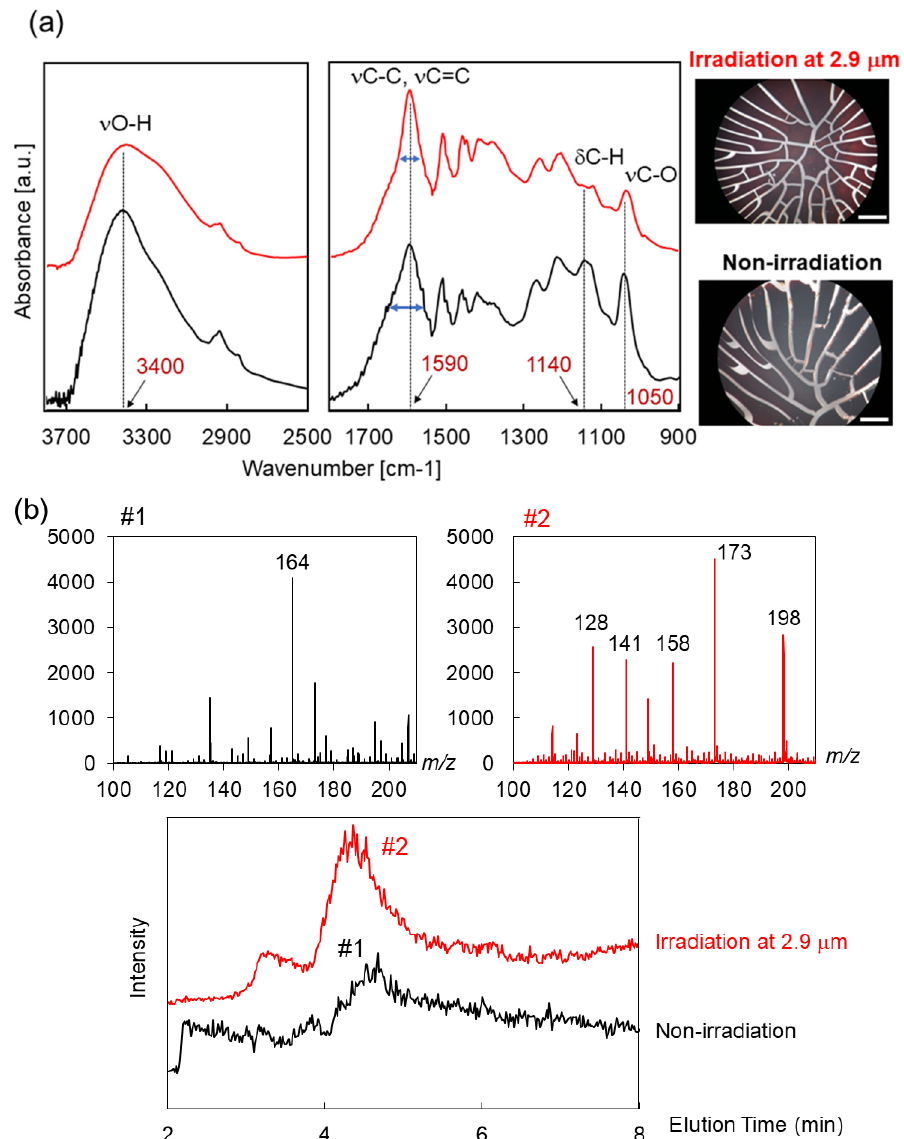
Figure 2. Irradiation effect of IR-FEL at 2.9 µ m. ( a ) Infrared microspectroscopy observation of lignin before irradiation (black) and after irradiation (red) at near-infrared (left) and mid-infrared (middle) regions. The right panels show optical microscope images for surfaces of the dry lignin before and after irradiation. White bar: 200 µ m. ( b ) ESI-MS chromatography analysis. Upper: mass spectra at low-molecular weight region; #1: lignin before irradiation; #2: lignin after irradiation. Below: mass chromatogram of a peak at 173 Da. Black: sample before irradiation; red: sample after irradiation.